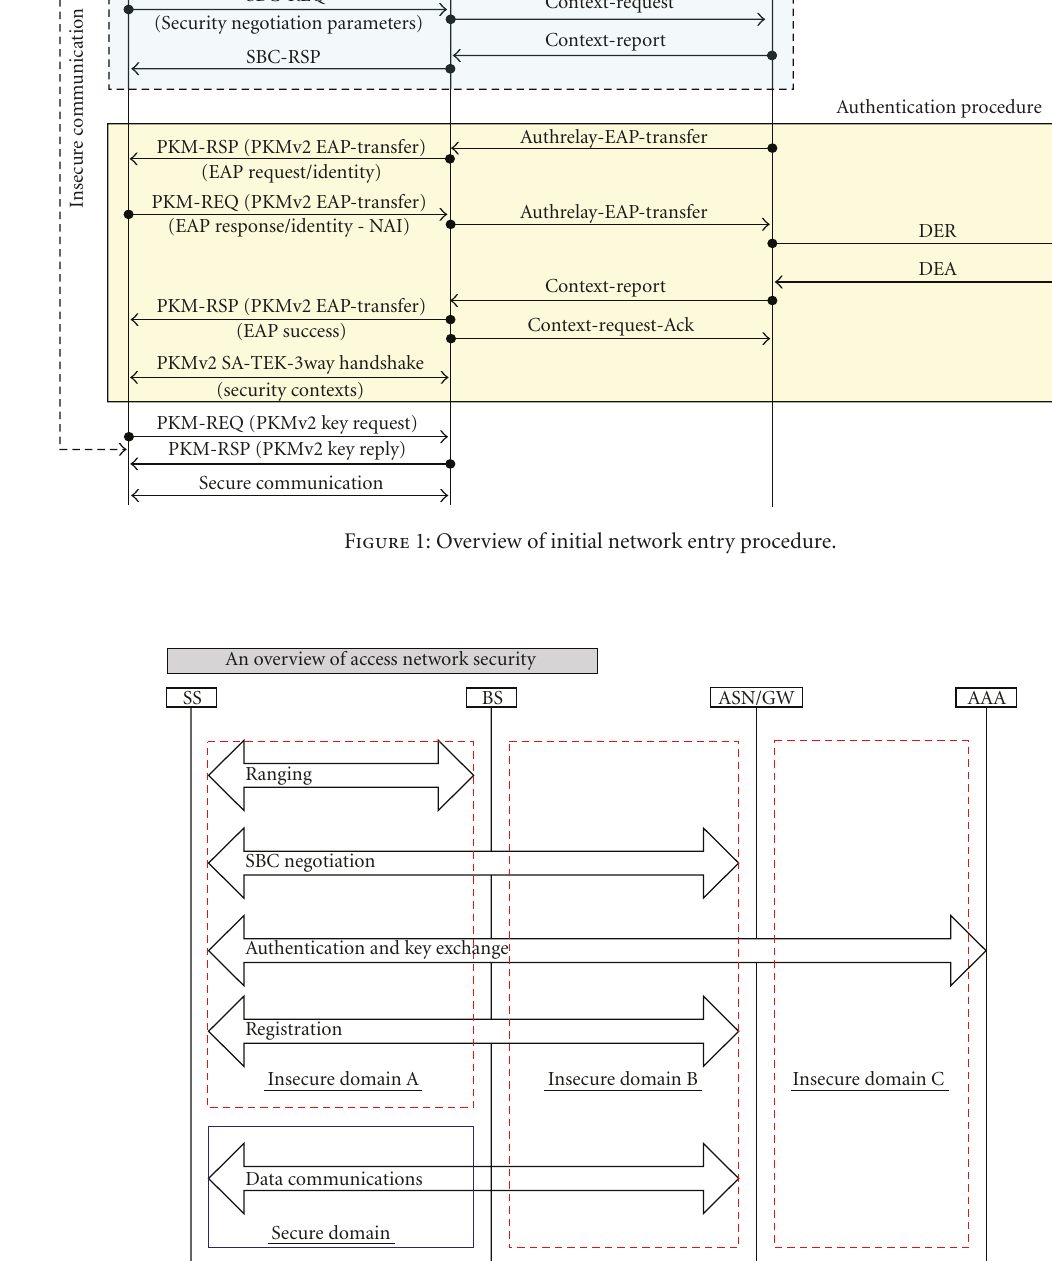
Figure 2: Overview of access network